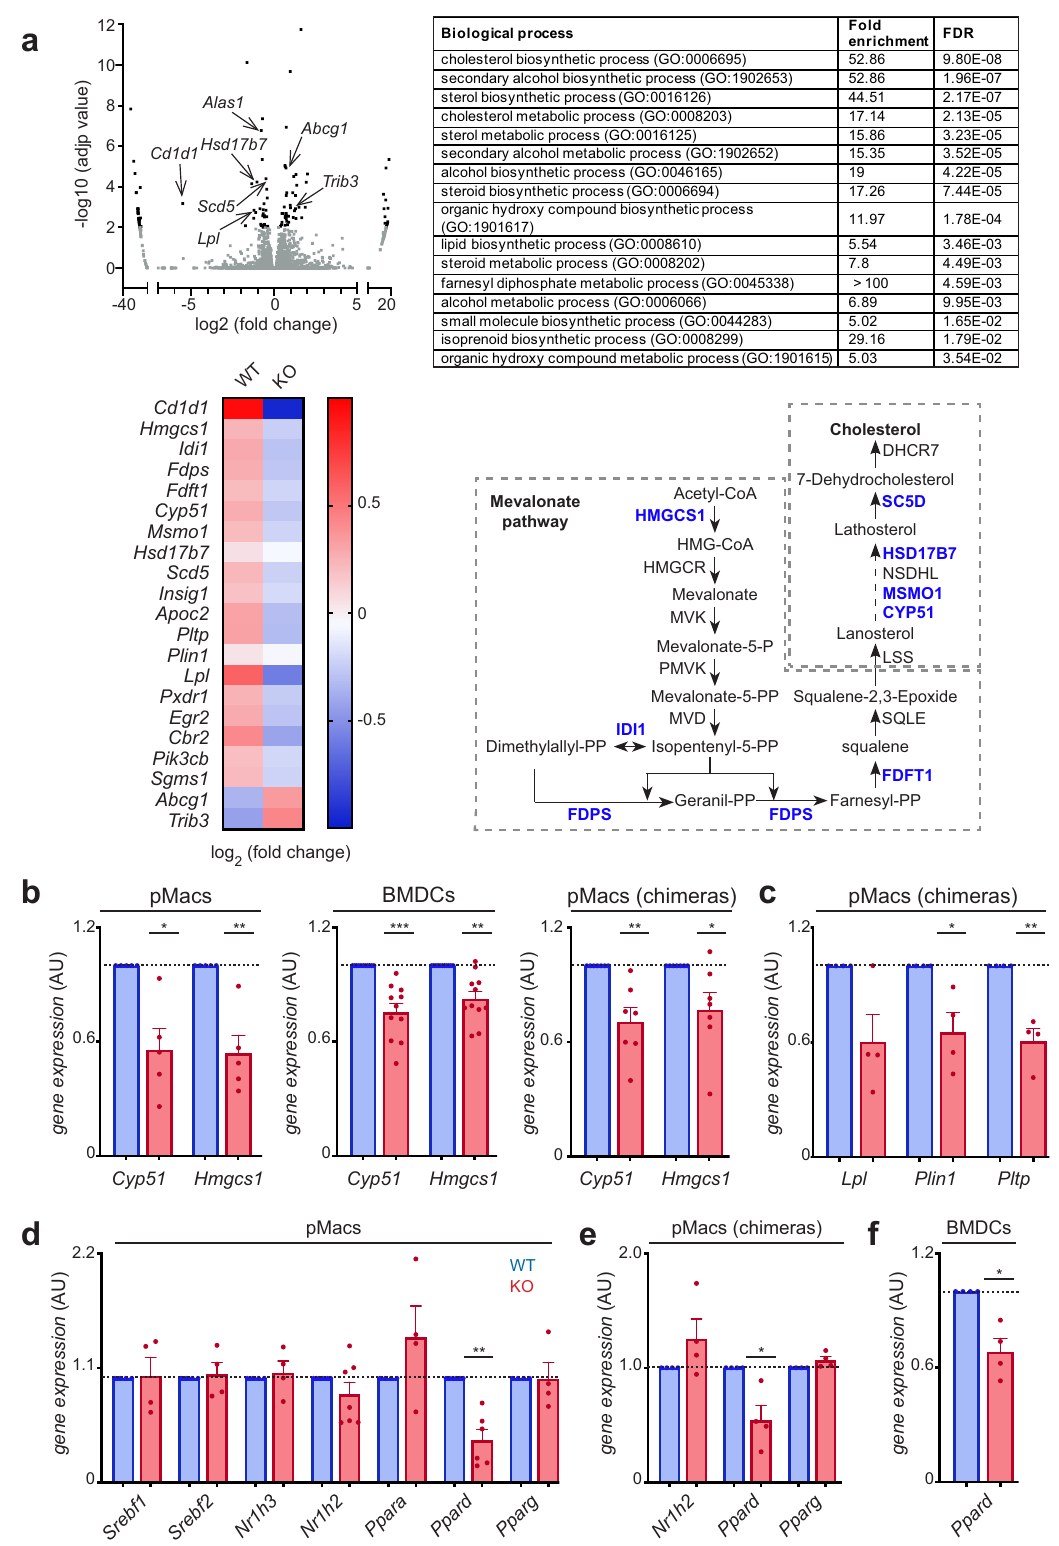
chromatography-tandem mass spectrometry (LC/MS/MS) to measure cholesterol as well as cholesteryl esters (CE) in unstimulated pMacs isolated from WT and CD1d-KO mice (Fig. 4a). On a per cell basis, the levels of total cholesterol as well as those of saturated (16:0, 18:0)